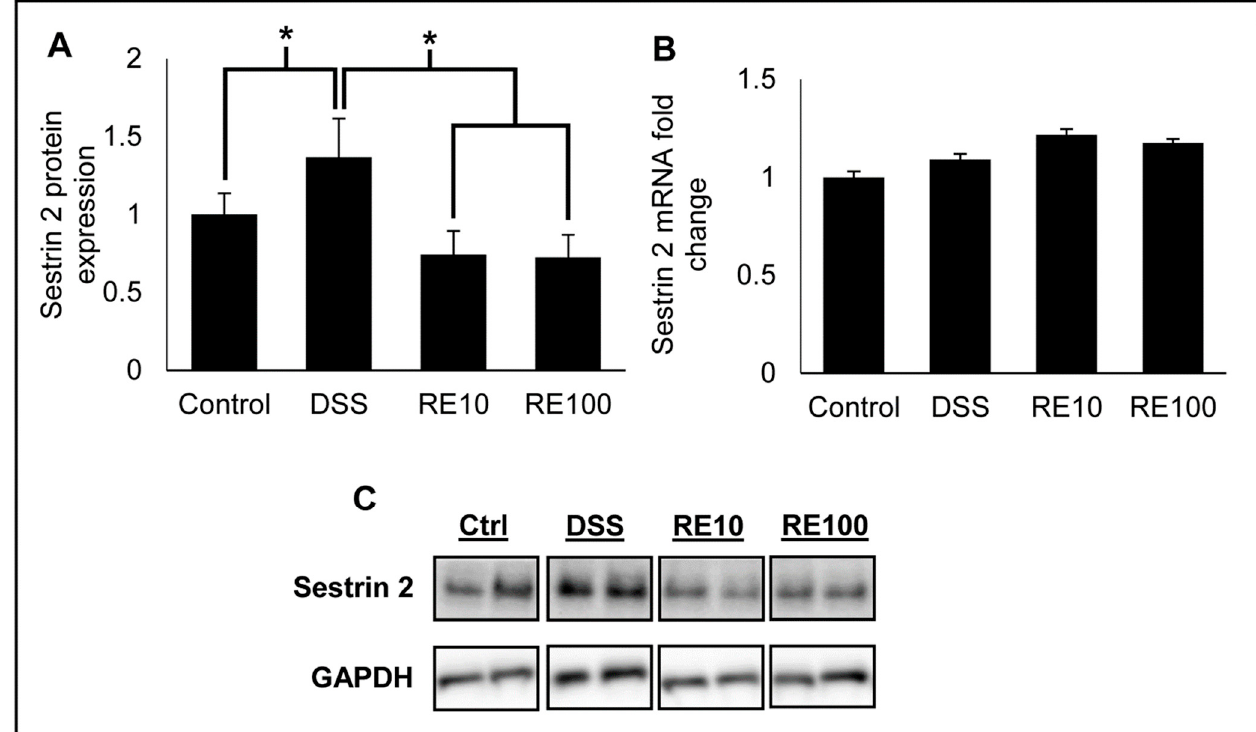
Figure 6. ( A ) Rosemary extract (RE) protected against increased sestrin 2 protein expression caused by DSS. Mouse intestinal lysates were analyzed for sestrin 2 protein expression by Western blot ( n = 7 samples per group). ( B ) Sestrin 2 mRNA analysis by qPCR showed that sestrin 2 mRNA was not significantly affected by DSS exposure or with RE pre-treatment. ( C ) Western blot images of sestrin 2 protein expression in mouse colon lysates representative of each group from the DSS colitis experiment. One-way ANOVA followed by Tukey’s HSD was used to determine significance. * p < 0.05.